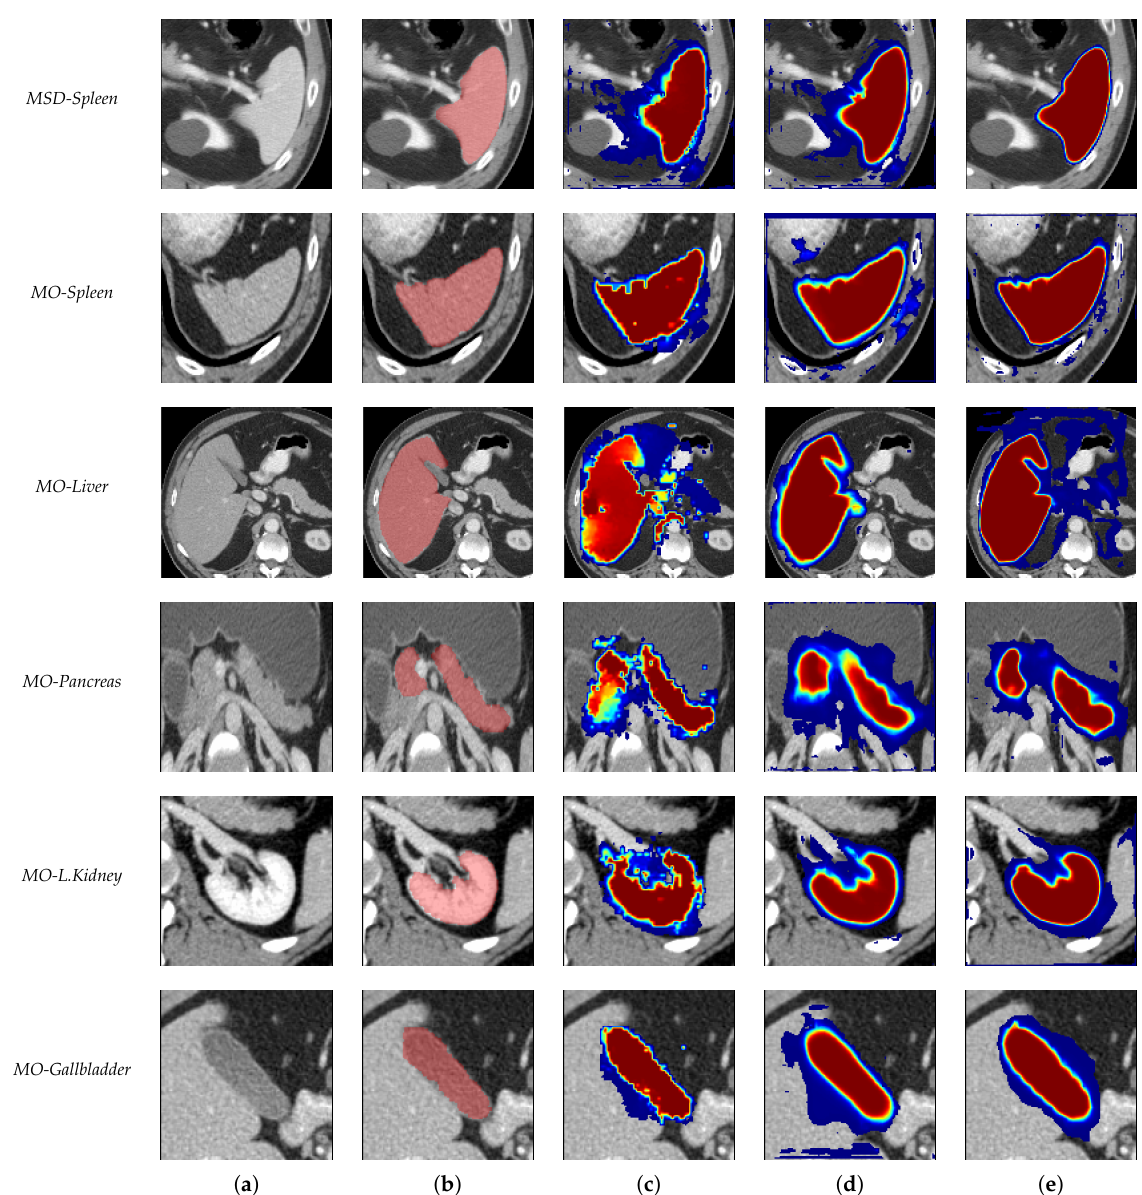
Figure 3. Our results on six different segmentation tasks on example cases from the validation set. We show ( a ) the image after cropping based on extreme points, ( b ) overlaid (full) ground truth (used for evaluation only), ( c ) initial random walker prediction, ( d ) our final segmentation result produced by the weakly supervised segmentation scheme, ( e ) the fully supervised result for reference. Specifically, we compare example cases for weak. sup. dextr3D (w RW) Dice + Point loss + Point Attn and fully sup. dextr3D Dice loss for ( d , e ), respectively. The probability maps are scaled between 0 and 1 and we show all non-zero